Question: How would you classify this visualization?
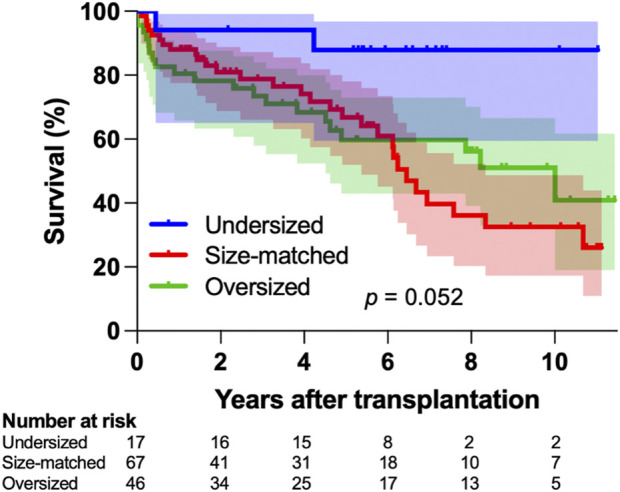
Answer: survival